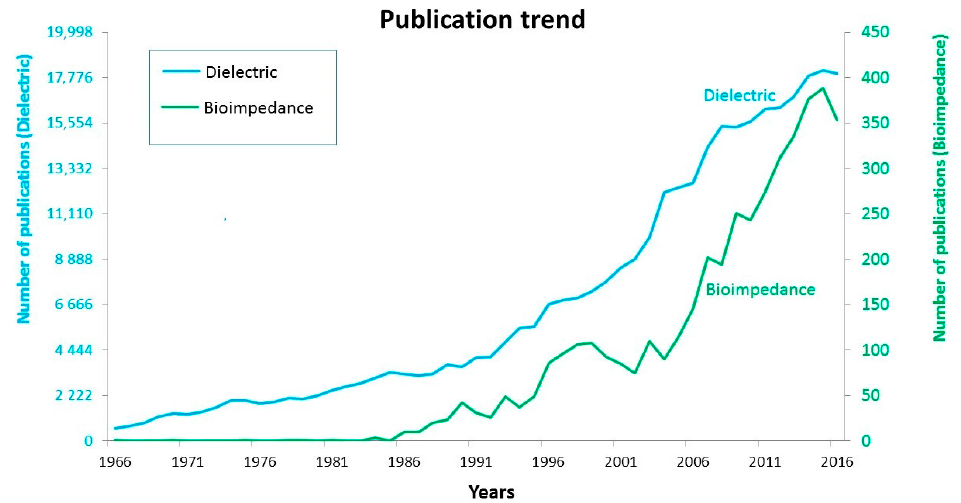
Figure 2. Comparison between evolution of bioimpedance and dielectric publication trends from 1966 till 2016.